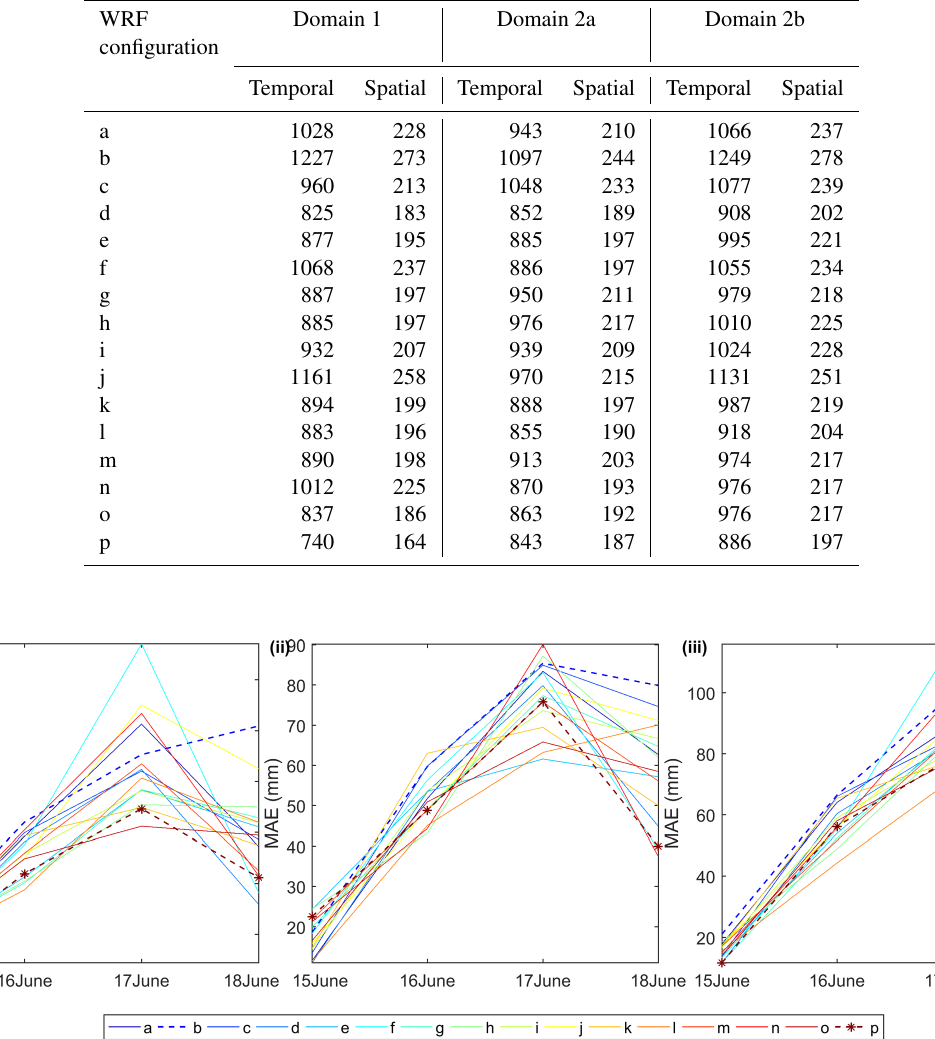
Figure B1. Mean absolute errors in space corresponding to different WRF configurations for (i) Domain 1, (ii) Domain 2a and (iii) Do- main 2b. Blue dotted lines present the “worst” performing configuration, i.e. configuration (b), and red dotted lines show the “best” perform- ing configuration, i.e. configuration